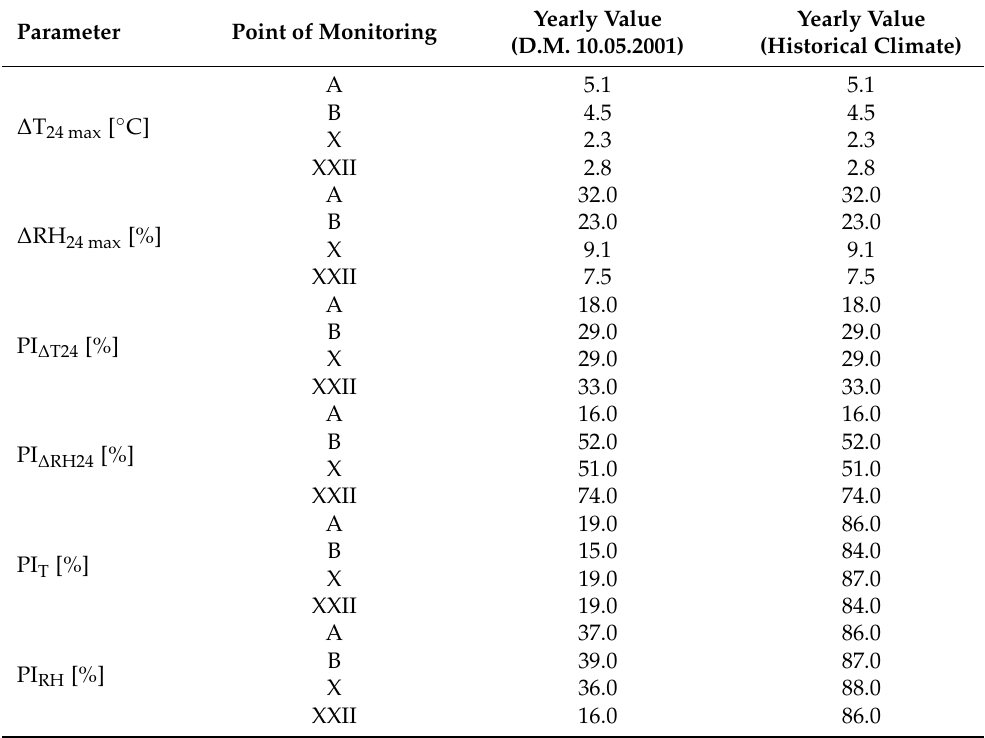
Table 7. Maximum yearly gradient and PI values of hygrothermal parameters in the four analyzed zones: A and B in Vasari Corridor and rooms X and XXII in La Specola